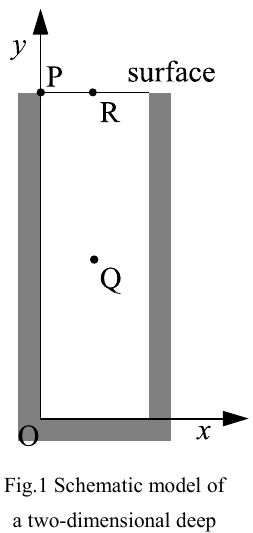
a two-dimensional